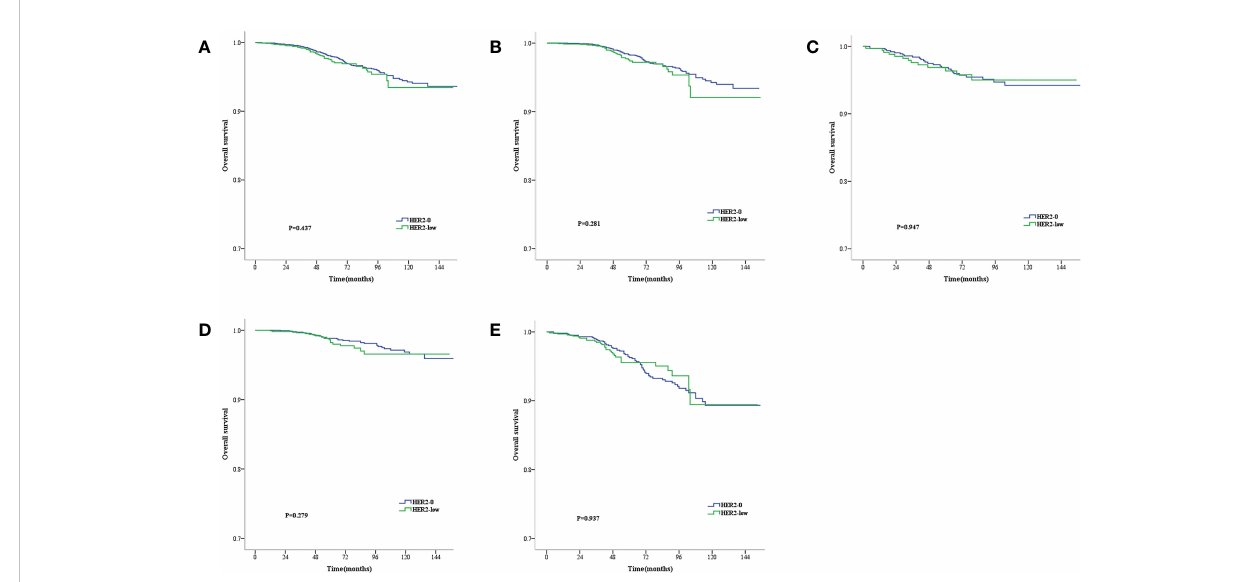
FIGURE 2 Kaplan – Meier survival curves for OS strati fi ed by hormone receptor (HR) status and lymph node status.OS for HER2-low vs. HER2-0 tumors in the complete cohort (A) , HR-positive population (B) , HR-negative population (C) , Lymph node-negative population (D) and lymph node-positive population (E) . p values are from the strati fi ed log-rank